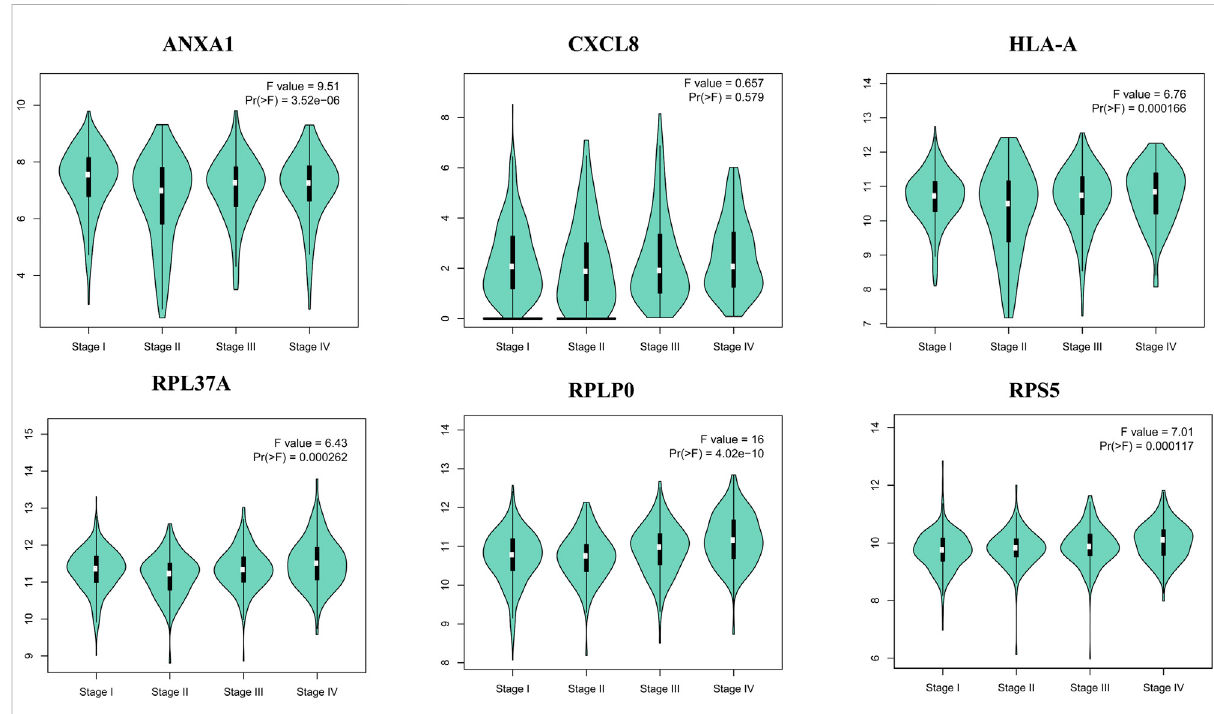
FIGURE 5 Violin plots of selected hub genes ANXA1, CXCL8, HLA-A, RPL37A, RPLP0, and RPS5 in kidney cancer.